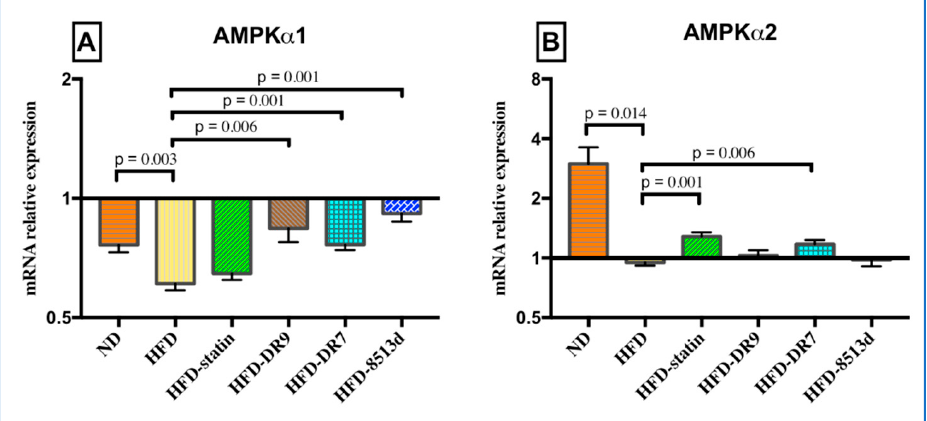
Figure 8. Relative gene expression of ( A ) AMPK α 1 ( B ) AMPK α 2 in liver of D-galactose-induced aging rats (600 mg / kg / day) after 12 weeks of treatment. ND (normal diet), HFD (high-fat diet), HFD-statin (high-fat diet, receiving lovastatin 2 mg / kg / day), HFD-DR9 (high-fat diet, receiving L. fermentum DR9 (10 10 CFU / day), HFD-DR7 (high-fat diet, receiving L. plantarum DR7 (10 10 CFU / day), HFD-8513d (high-fat diet, receiving L. reuteri 8513d (10 10 CFU / day). Results are expressed as mean; error bars (SEM); n = 6. Statistical analysis was performed using independent t -tests.